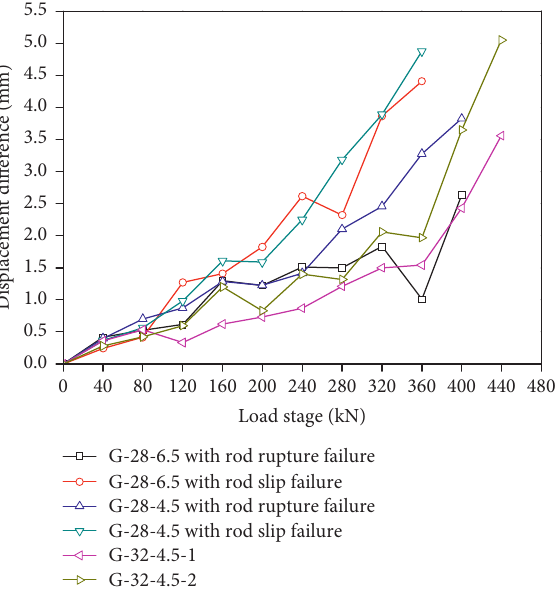
Figure 19: Summary of the load-displacement difference curves between the anchor rod and anchorage